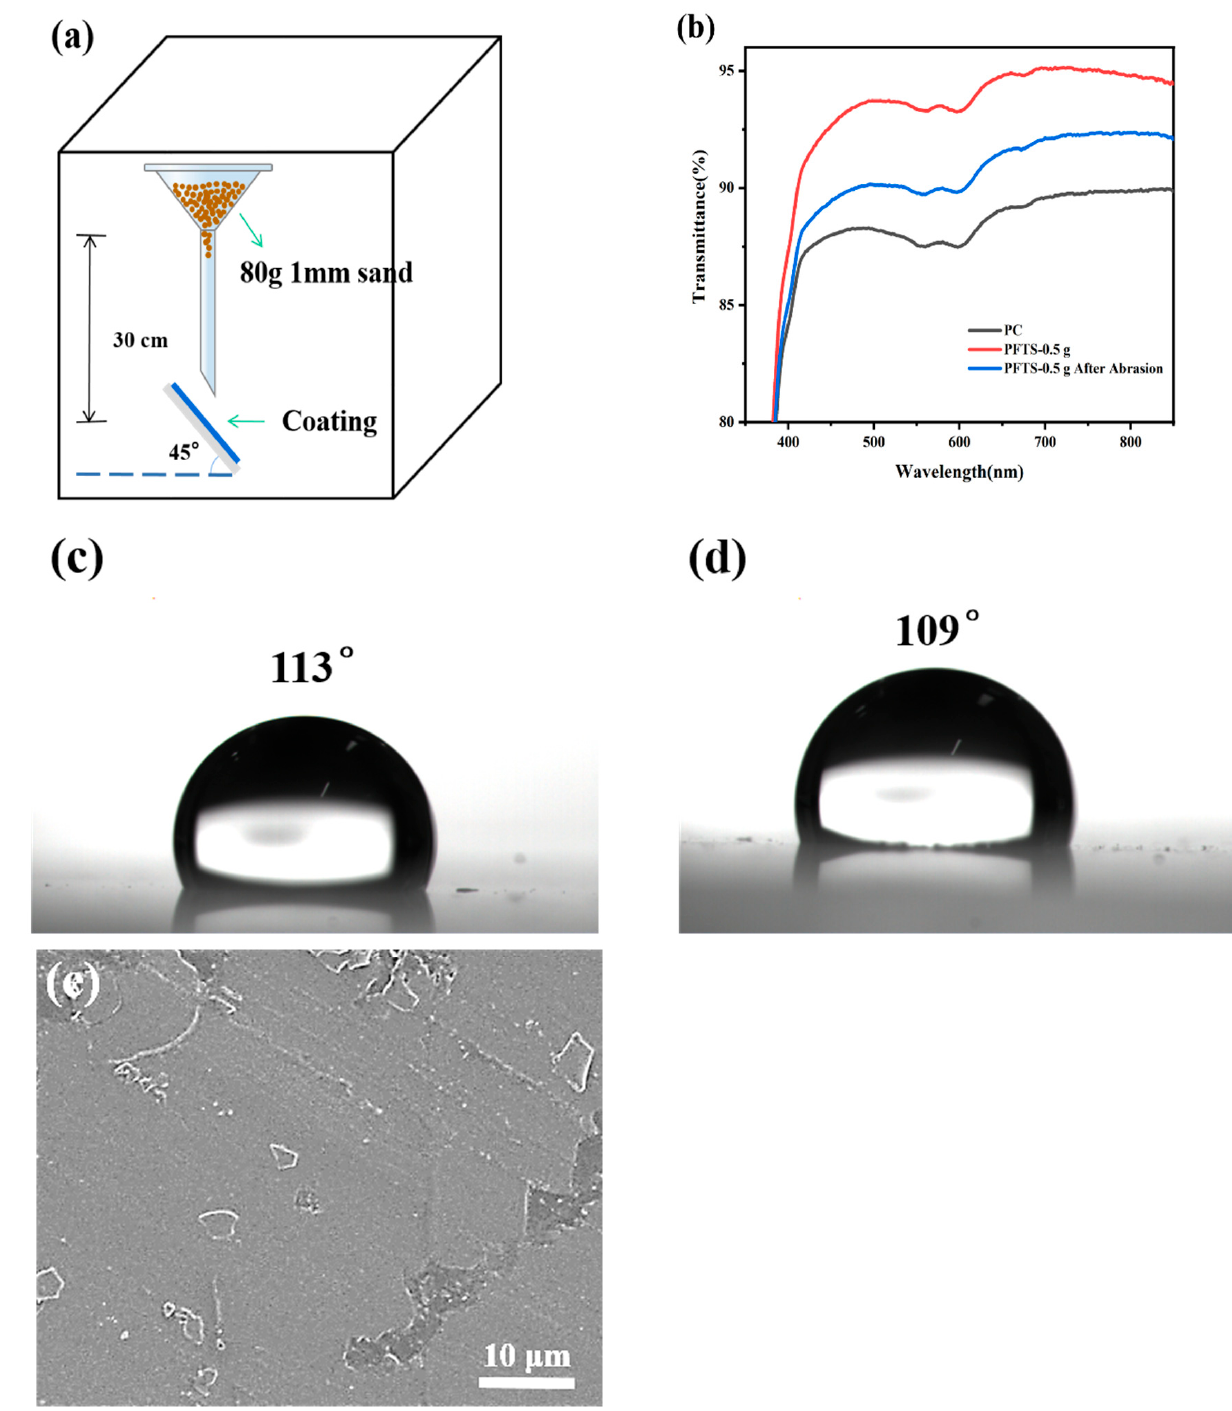
Figure 8. ( a ) Schematic diagram of the sand hit test, ( b ) Transmittance spectra, ( c , d ) WCA and ( e ) SEM images of the sample after the sand hit test.